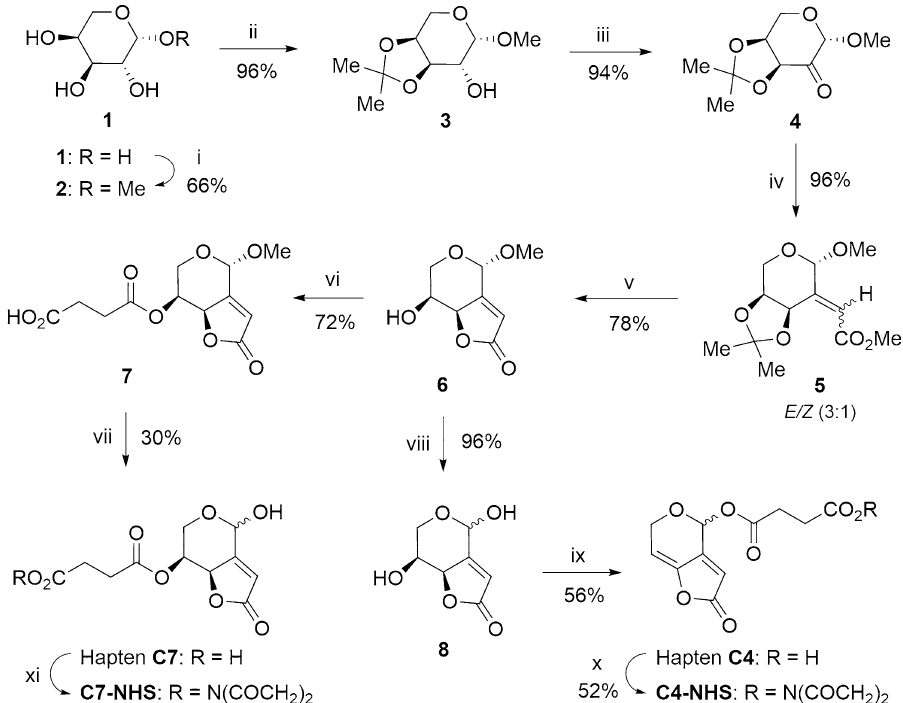
Figure 2. Synthetic route for the preparation of haptens C4 and C7 . Reagents and conditions: (i) AcCl, MeOH, 50 °C, 4 h; (ii) p-TsOH, Me 2 C(OMe) 2 ; acetone, rt, 22 h; (iii) (COCl) 2 , DMSO, CH 2 Cl 2 , − 78 °C, 30 min, then Et 3 N, − 78 °C to rt, 1 h ; (iv) Ph 3 P = CHCO 2 Me, benzene, 50 °C, 6 h; (v) HCl 1.2 M, MeOH, reflux, 2.5 h; (vi) (CH 2 CO) 2 O, DMAP, THF, rt, 16 h; (vii) TFA/H 2 O (9:1), 45 °C, 16 h; (viii) TFA/H 2 O (9:1), 50 °C, 16 h; (ix)